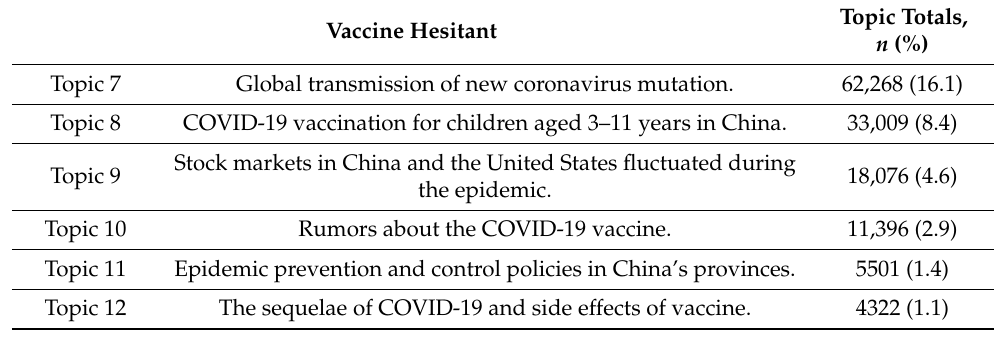
Table 2. The six most significant vaccine-related topics of the vaccine-hesitant group ( n = 392,971).